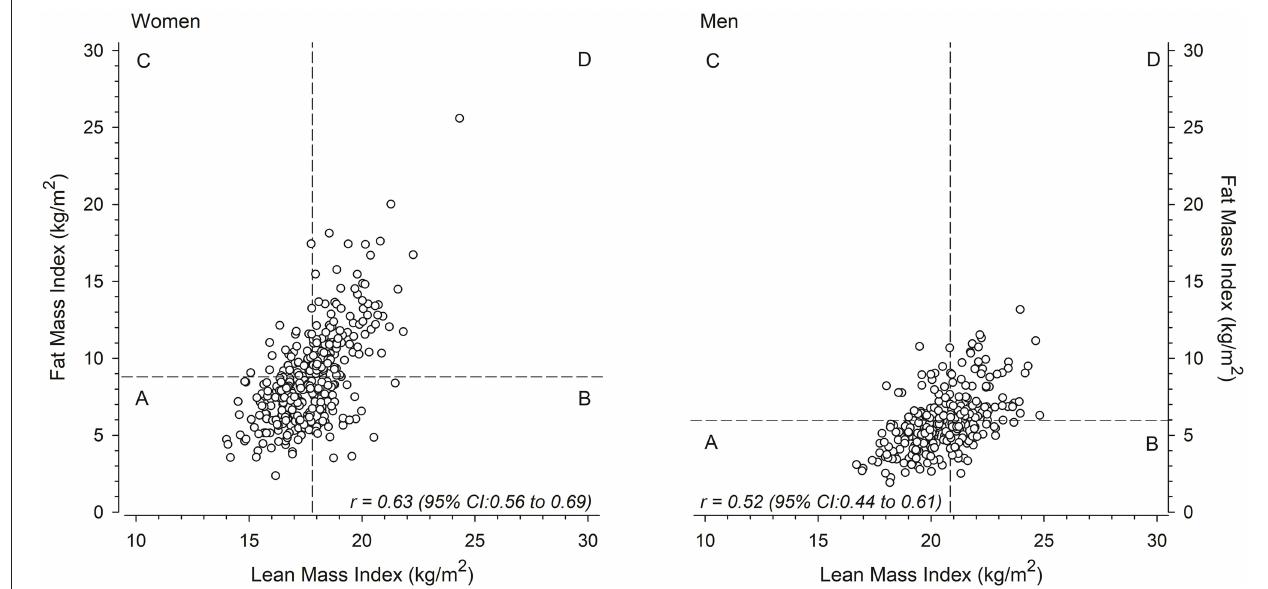
FIGURE 1 | Mean lean mass index-fat mass index scatter plots for women (left) and men (right) divided into four groups (A, B, C, D) around the sex-specific median.